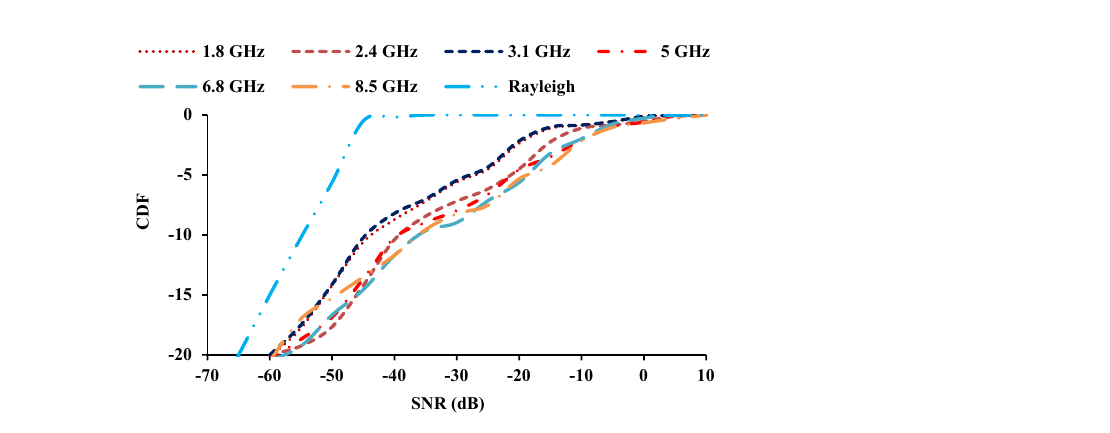
Figure 16. CCL of the MIMO antenna: ( a ) with respect to port-1 and ( b ) with respect to port-12.